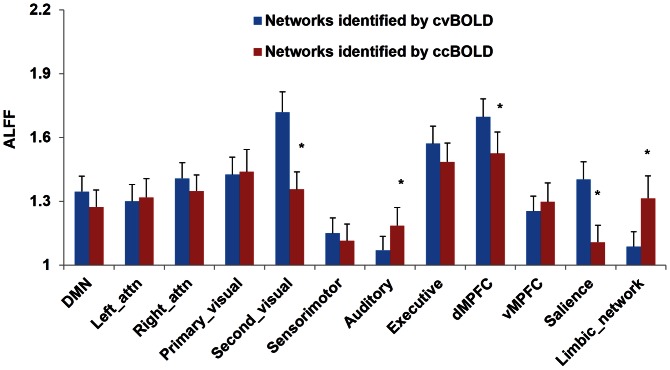
Mean ALFF values extracted from the 12 resting-state networks by ICA analyses.Significant difference was observed in the primary visual, auditory, DMPFC, salience and limbic network. Error bar represented standard error. * p<0.05.